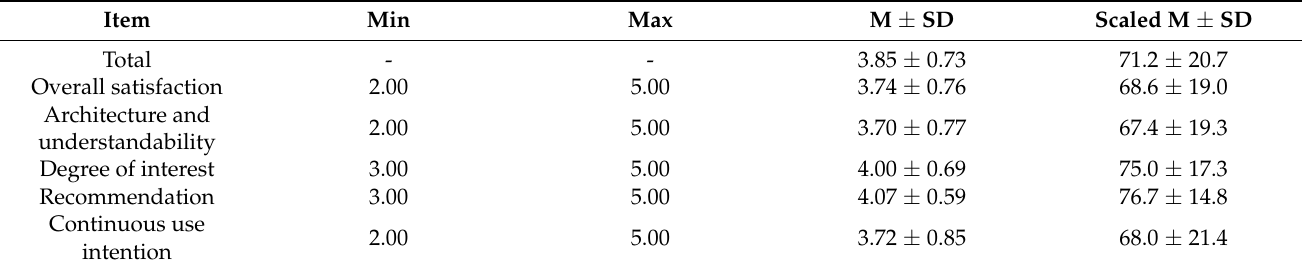
Table 6. Satisfaction evaluation results (N = 43, Unit: